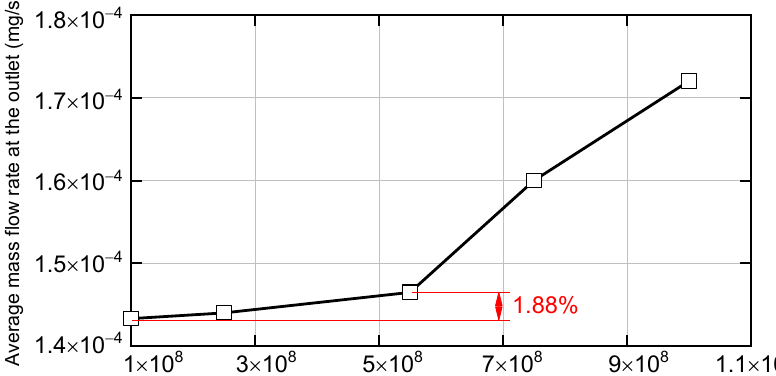
Figure 10. Effect of equivalent molecular number of nitrogen molecular sample package.